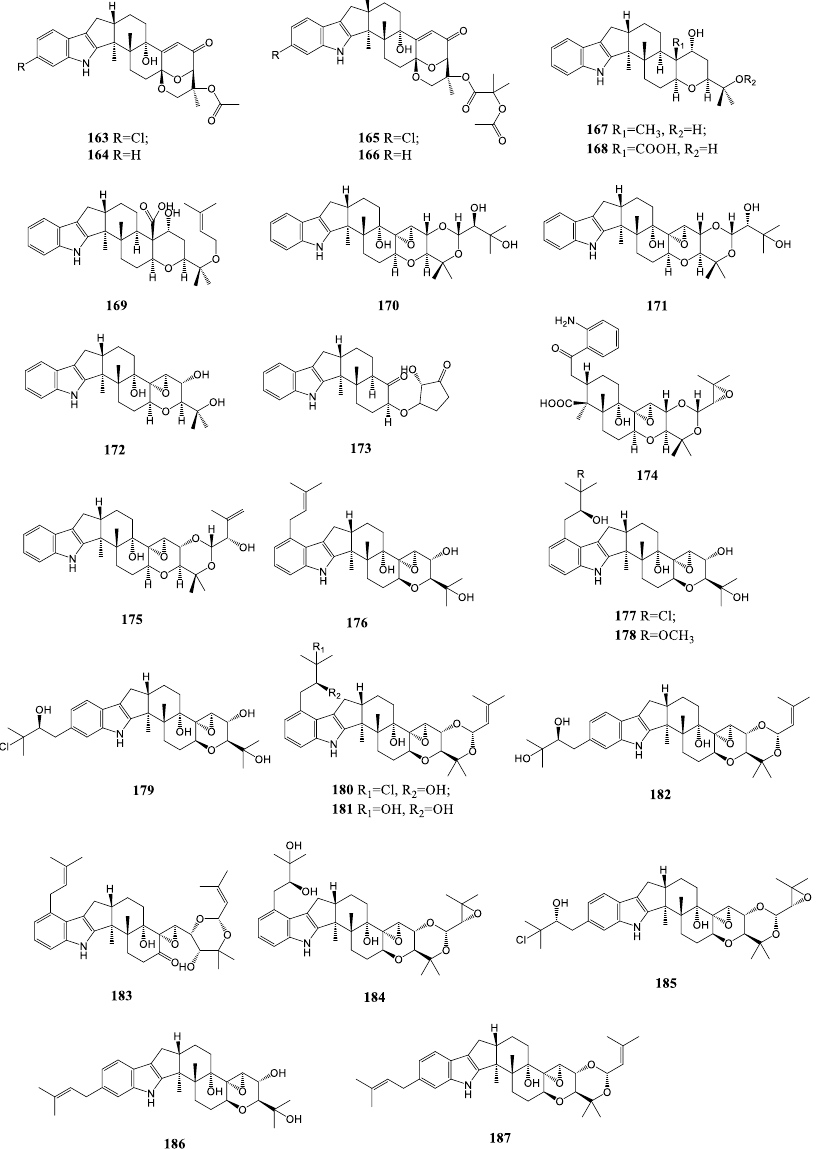
Figure 8. Other paxilline-type indole diterpenes.